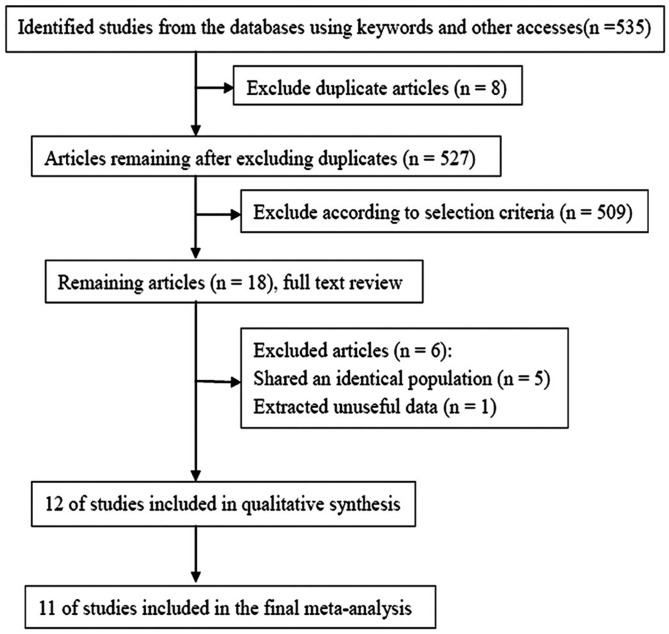
Study flow diagram.